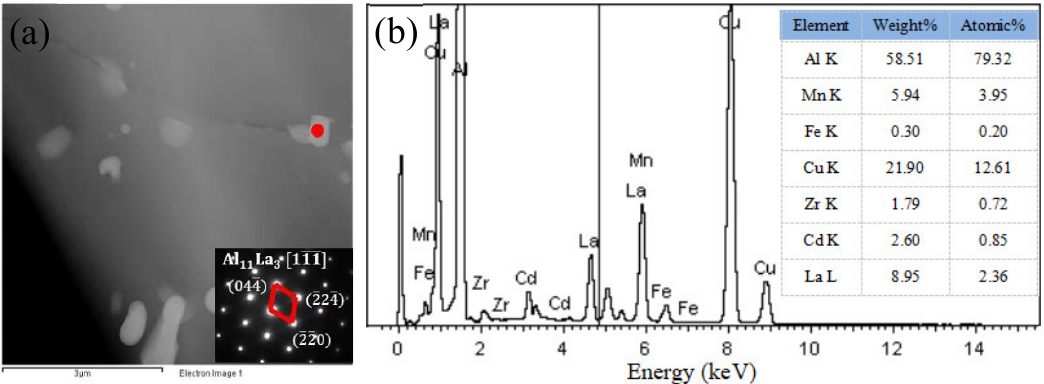
Figure 16. Al–La phase in ZL205A + 0.3%Al–5Ti–0.8C + 0.1%La alloy (T5 heat treatment): ( a ) the electron diffraction spots (dark field), ( b ) the electron energy spectrum.